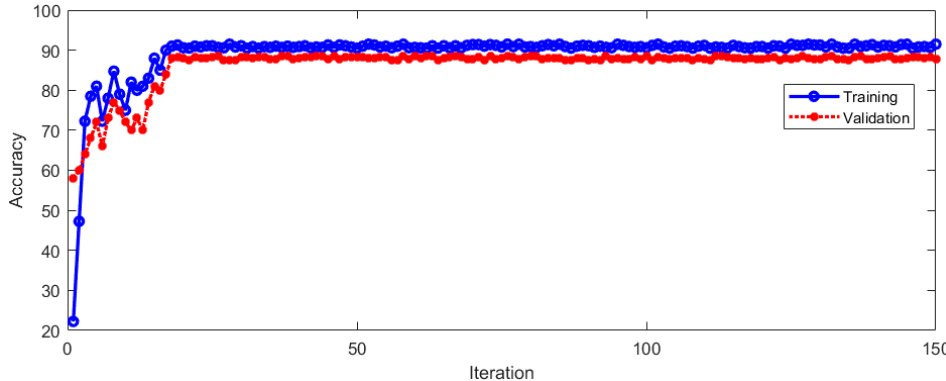
Figure 15. Recognition accuracy in training and verification process.